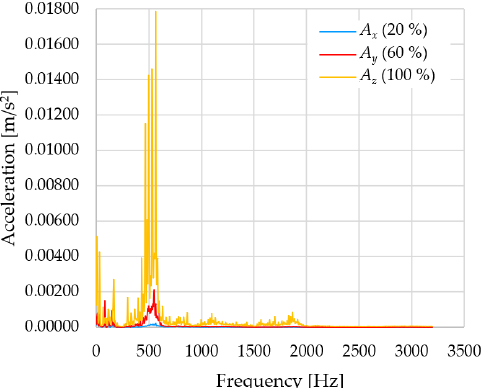
Figure 14. Acceleration waveforms depending on frequency in Z -axis for velocity 20, 60 and 100%.